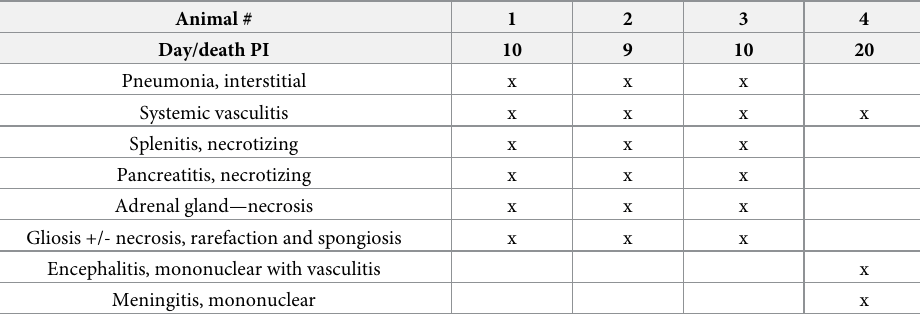
Table 1. Summary of histologic